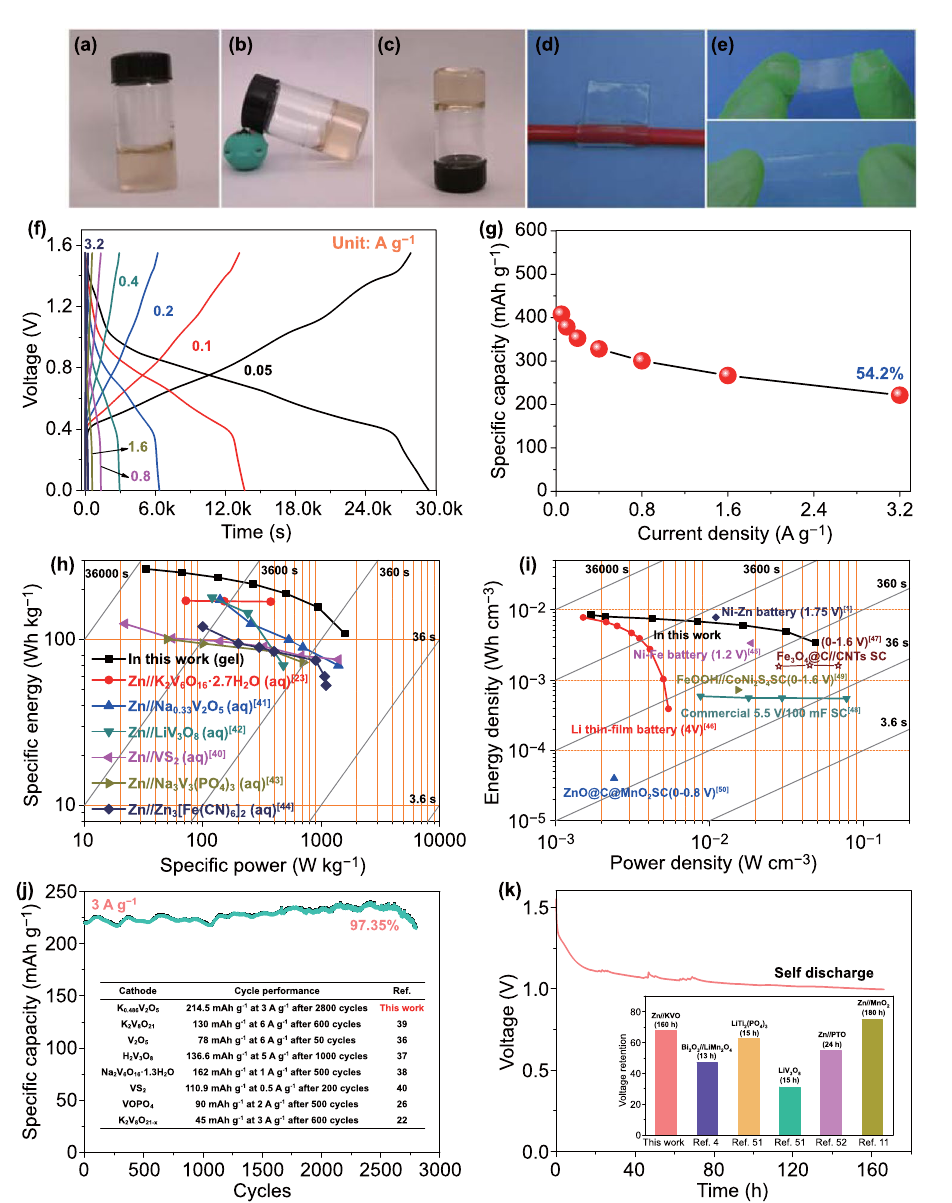
Fig. 5 Photographs of gel electrolyte with a–c quasi-solid, d flexible and e stretchable characteristics. f Charge–discharge profiles of quasi- solid-state Zn//KVO cell. g Rate performance. Ragone plots of the device based on h cathode mass and i the volume of the device. Data from previous studies are included for comparison [1, 23, 40–50]. j Cyclic performance and the comparison with literature values (inset table) [22, 26, 36–40]. k Self-discharge curve and the comparison with previous batteries [3, 11, 51,